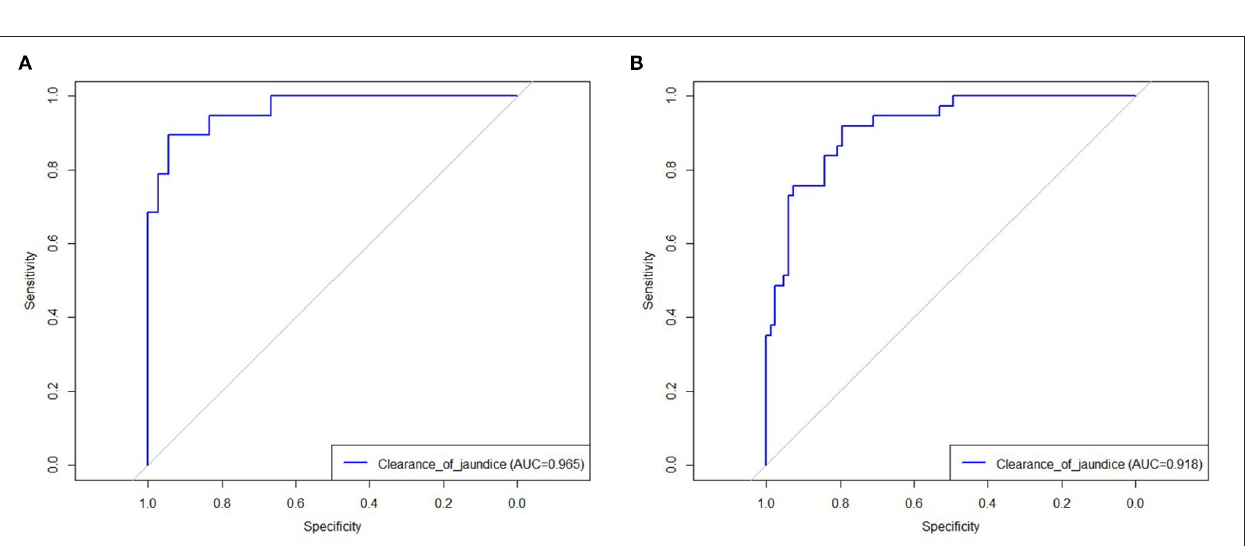
FIGURE 3 | The receive operating characteristic of established model in training (A) and testing cohort (B)